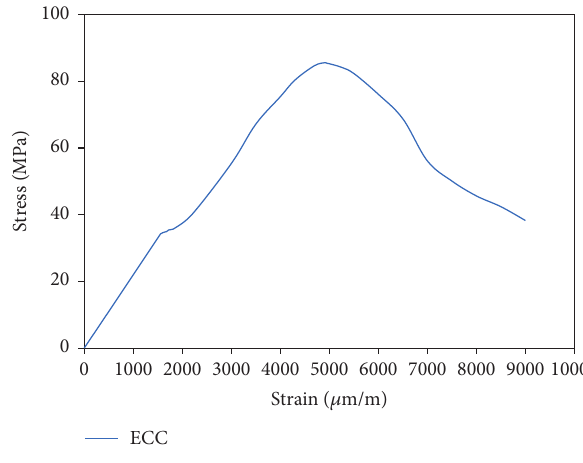
Figure 18: Compression stress-strain curve: ECC.